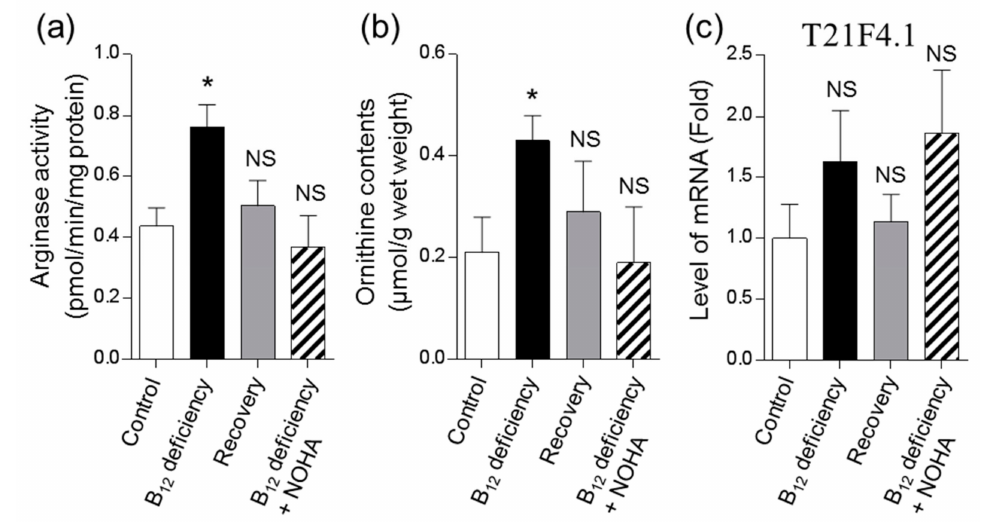
Figure 4. E ff ects of vitamin B 12 deficiency on arginase activity and the mRNA expression of the arginase orthologous gene, T21F4.1, in C. elegans . Arginase activity ( a ), ornithine contents ( b ), and mRNA expression levels of arginase orthologous gene, T21F4.1, ( c ) were determined in B 12 -deficient and control worms. After B 12 -deficient worms were grown for three generations under B 12 -supplemented conditions, these values were determined in the B 12 -treated worms (shown as “Recovery”). After B 12 -deficient worms were treated with N ω -hydroxy-L-arginine (NOHA) as a potent inhibitor of arginase, these values were determined (shown as “B 12 deficiency + NOHA”). Data represent the mean ± SEM of three independent experiments. * p < 0.05 versus Control group. NS represents no significant di ff